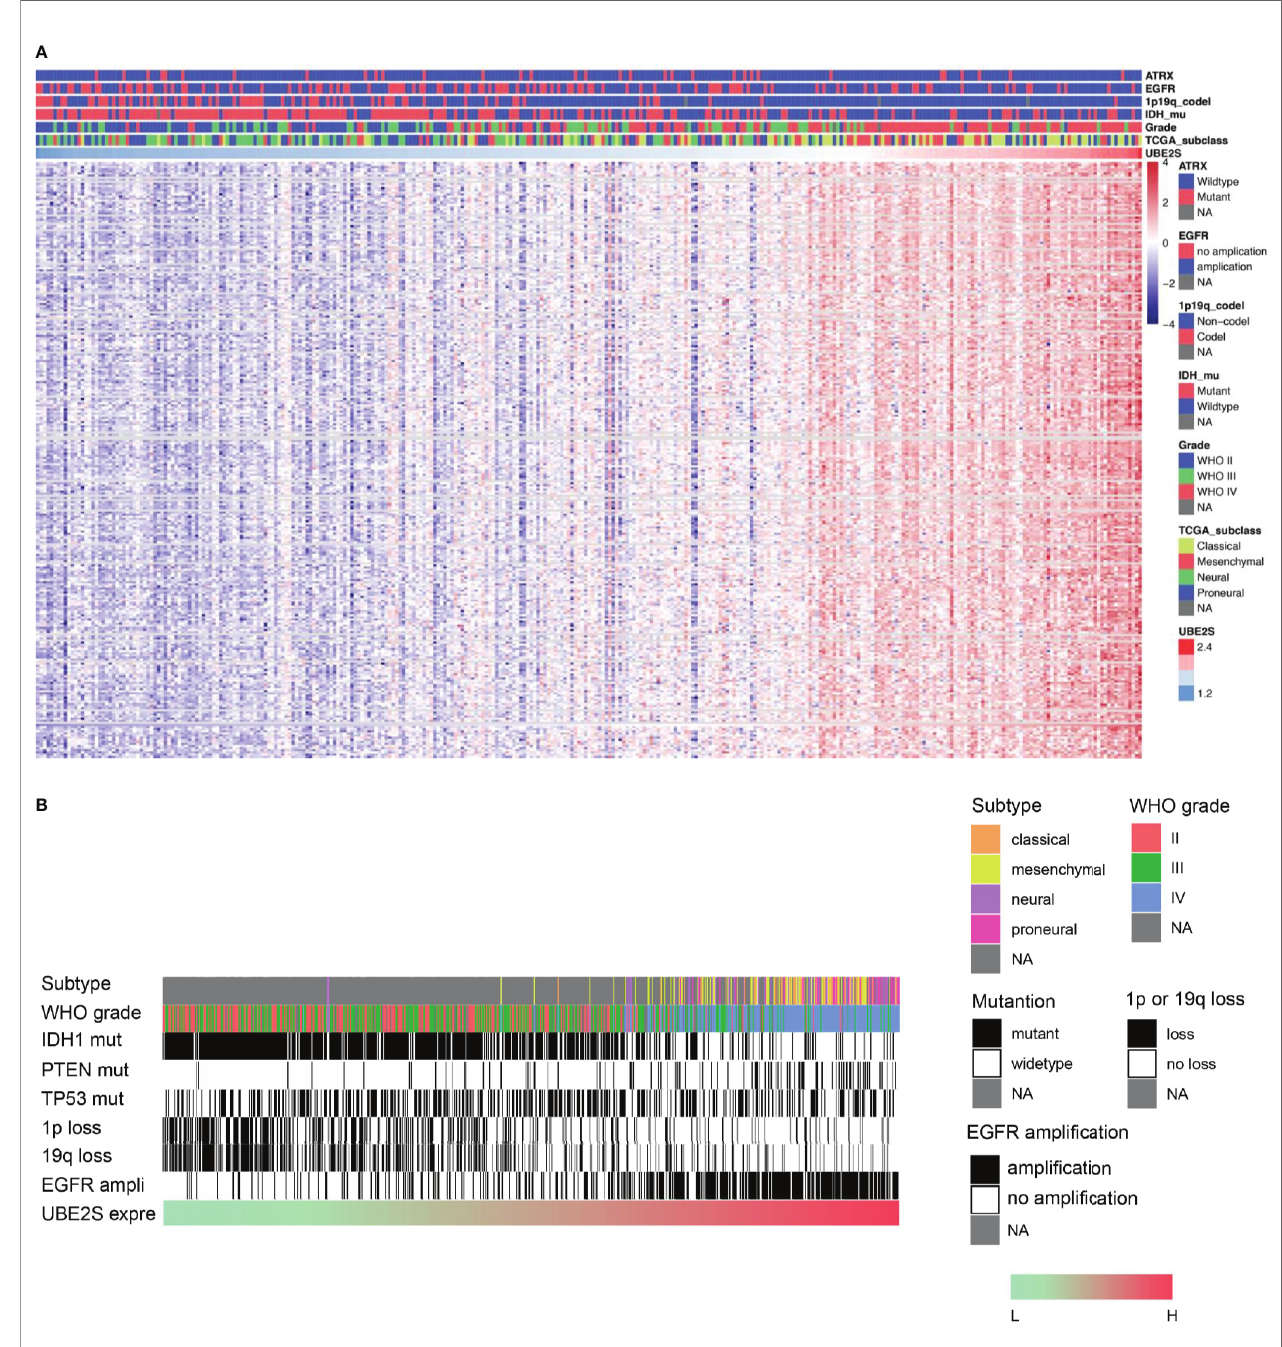
FIGURE 3 | Correlations between UBE2S expression level with the classical genomic or transcriptional alterations in glioma. (A) Correlations between UBE2S expression level and the classical genomic or transcriptional alterations in whole grade glioma in CGGA data set. (B) Correlations of UBE2S expression level and the classical genomic or transcriptional alterations in whole grade glioma in TCGA data set. Pearson correlation analyses were